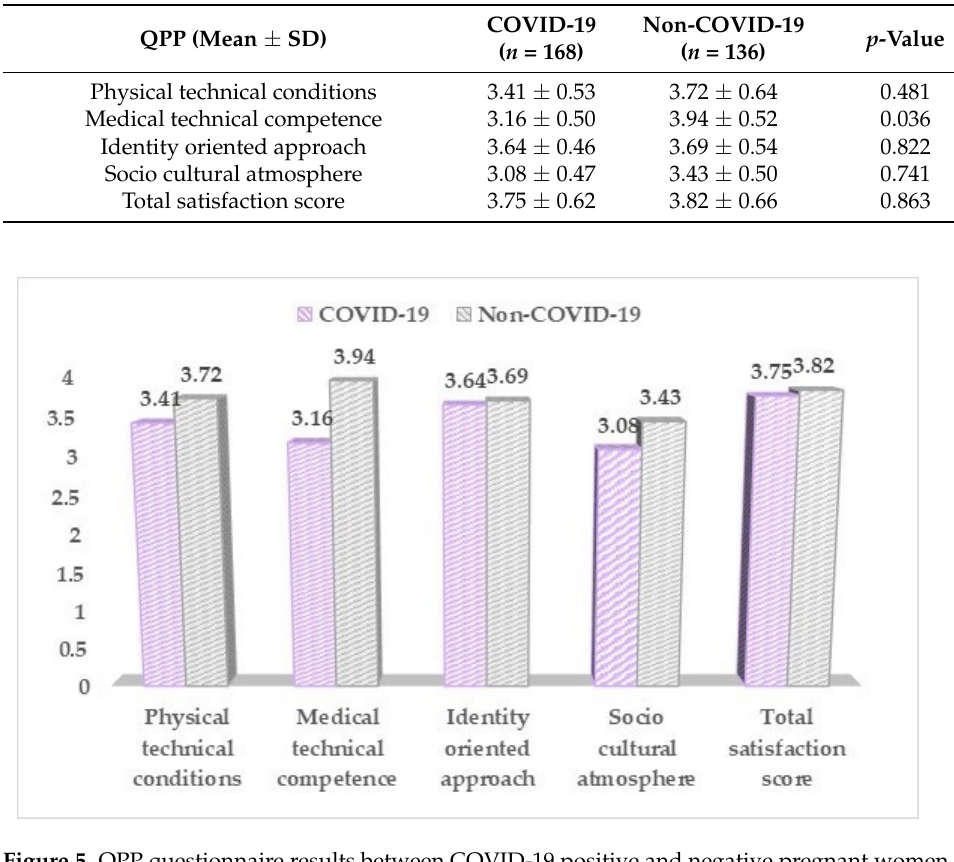
Figure 5. QPP questionnaire results between COVID-19 positive and negative pregnant women.